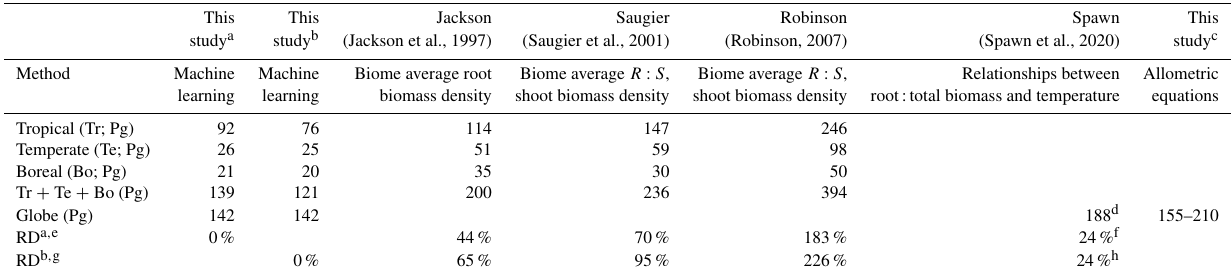
Table 1. Comparison between studies quantifying root biomass in tropical, temperate and boreal forests.